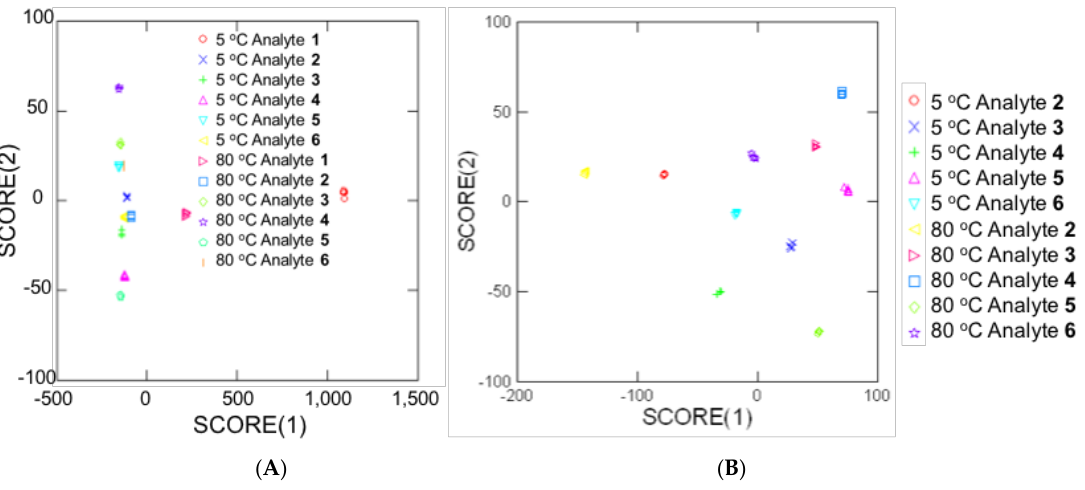
Figure 4. Array-based detection of ( A ) analytes 1 – 6 ; ( B ) analytes 2 – 6 with fluorophores 7 – 9 in γ- cyclodextrin solutions at 5 °C and 80 °C. γ -cyclodextrin solutions at 5 ◦ C and 80 ◦